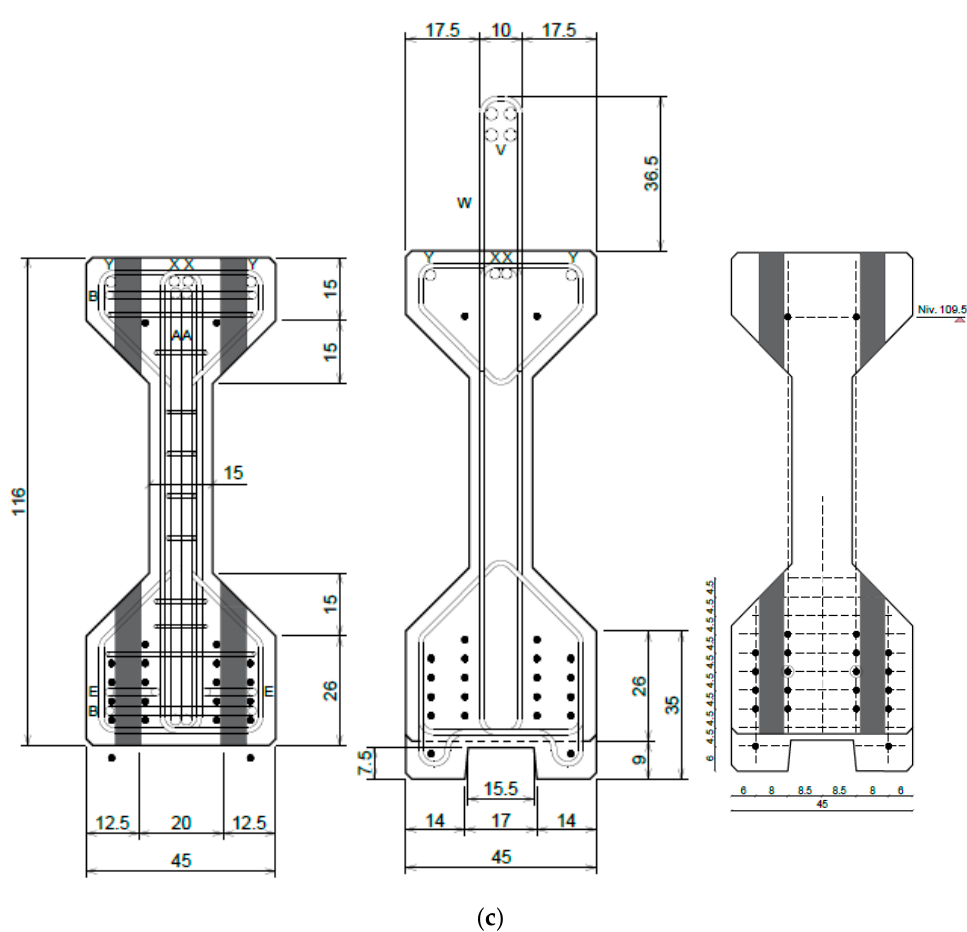
Figure 1. Geometry of cross sections AA and BB and the position of the strands (dimensions in cm): ( a ) Section AA; ( b ) Section BB; ( c ) Strand position.